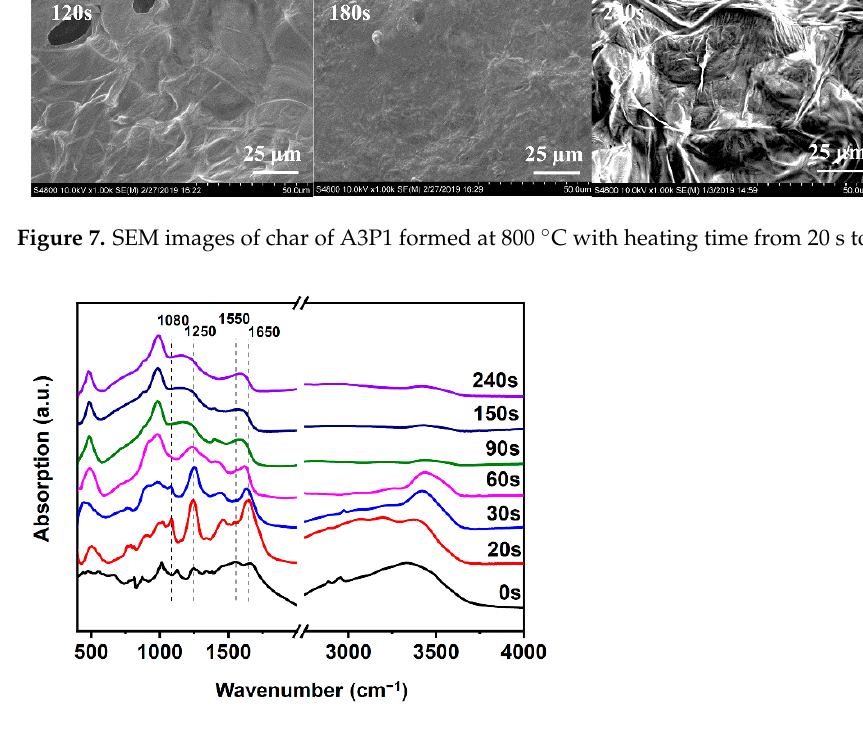
Figure 8. FTIR spectra of A3P1 resin and its char formed at 800 °C with different heating